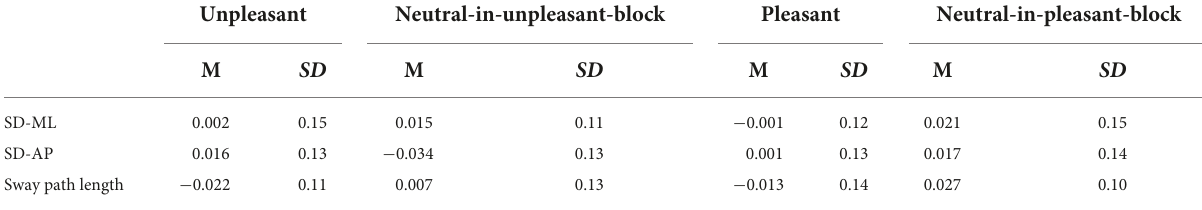
TABLE 1 Body sway measures per